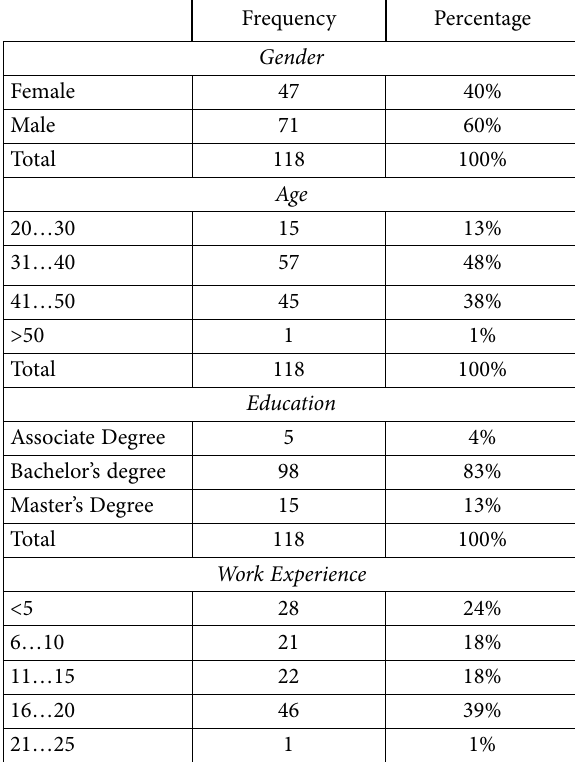
Table 1. Characteristics of